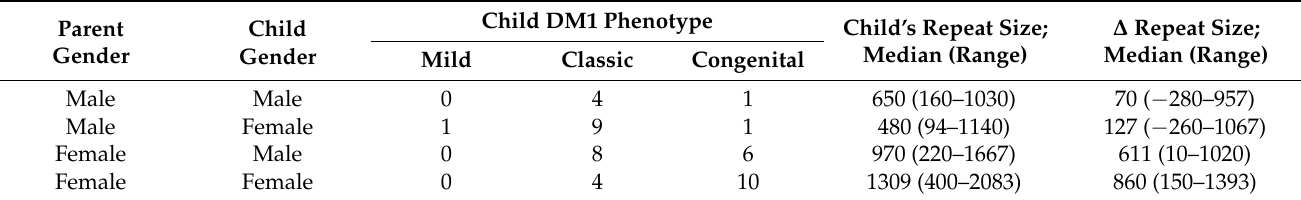
Table 1. DM1 phenotypes and CTG repeat size of the DMPK in the affected child according to the gender of the transmitting parent and the affected child in 44 Korean parent–child matched pairs diagnosed with